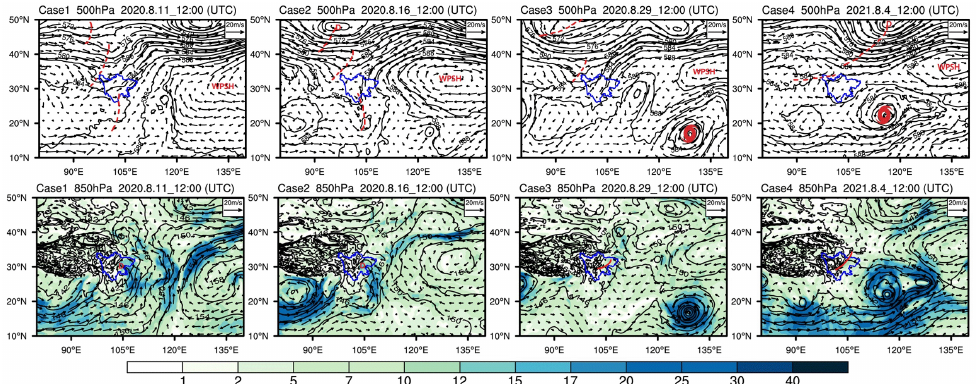
Figure 4. The geopotential height (black contours in dagpm), wind vectors (black arrows, ms − 1 ) and water vapour flux (shaded in g/(cm ∗ hPa ∗ s)) for four cases. The blue line represents the Sichuan provincial boundary. The red dashed lines represent the troughs while solid lines are shear lines. The Western Pacific Subtropical High locations and the center of the Tropical Cyclones are also